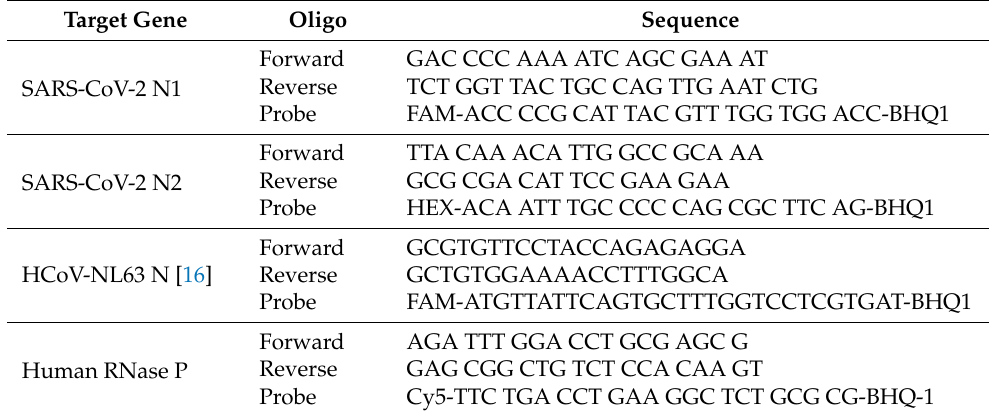
Table 1. List of primer/probe sequences